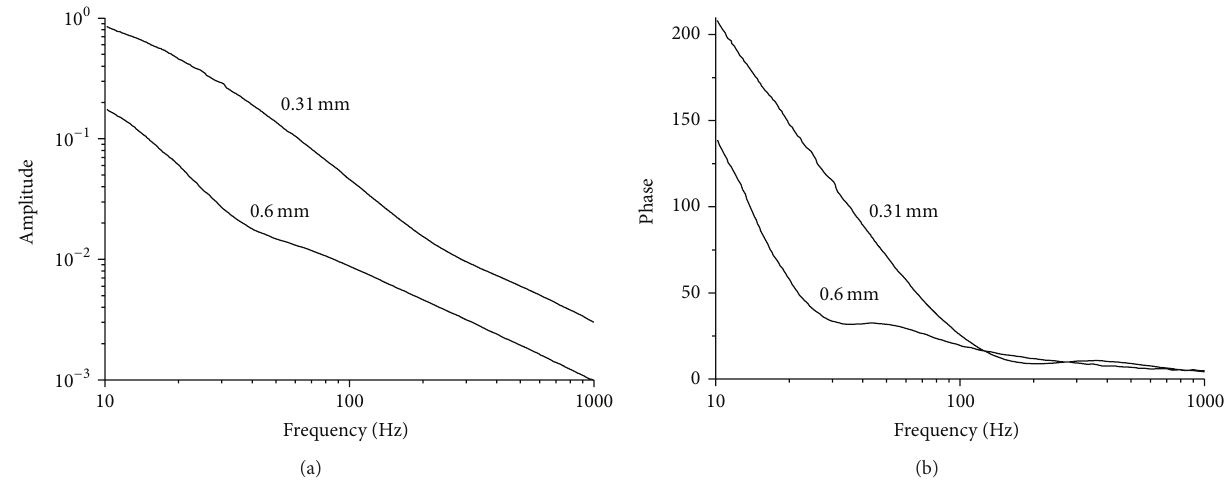
Figure 9: PA amplitude (a) and phase spectra (b) for PbTe doped with 1.7at% Au for two different sample thicknesses.